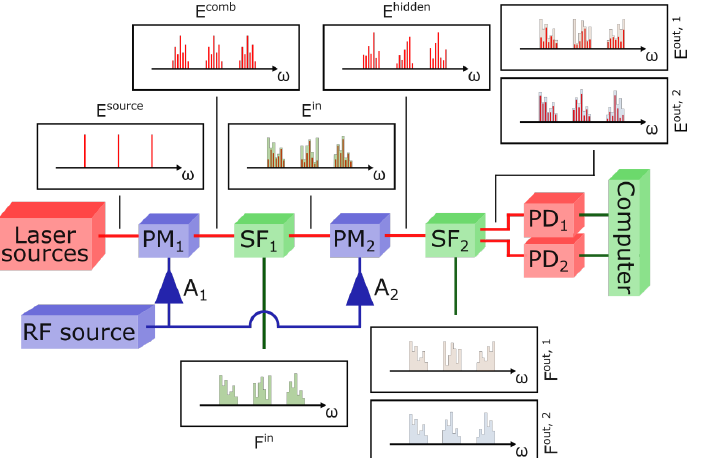
Figure 1. Scheme of the experimental setup. Red lines represent optical connections, green lines represent data connection to and from the computer, and blue lines represent RF connections. A 1 and A 2 represent two RF amplifiers. The first Phase Modulator, PM 1 , generates a frequency comb out of each line in the spectrum of the light source, E source . The first programmable Spectral Filter, SF 1 , encodes input features in these combs, thus generating the input layer E in (or the set of input layers, in the case of parallel operations). The filter shape loaded onto SF 1 , F in , is calculated according to the features to be encoded. The second Phase Modulator, PM 2 , mixes the components of E in , thus generating the hidden layer E hidden (or the set of hidden layers, in the case of parallel operations). The second programmable Spectral Filter, SF 2 , is employed for the readout and can apply two different filter shapes ( F out, 1 and F out, 2 ) to its two outputs, generating E out, 1 and E out, 2 . The photodiodes PD 1 and PD 2 measure the total intensities in E out, 1 and E out, 2 , respectively. A computer drives the programmable filters (connections not shown) and records the photodiode measurements. To measure the hidden layer, the combs are scanned one line at a time by programming SF 2 with notch filters. The output can then be computed offline as a linear combination of the intensities of the spectral lines. The figure shows a possible implementation of optical weighting, as demonstrated in [19], where SF 2 applies attenuations proportional to the desired